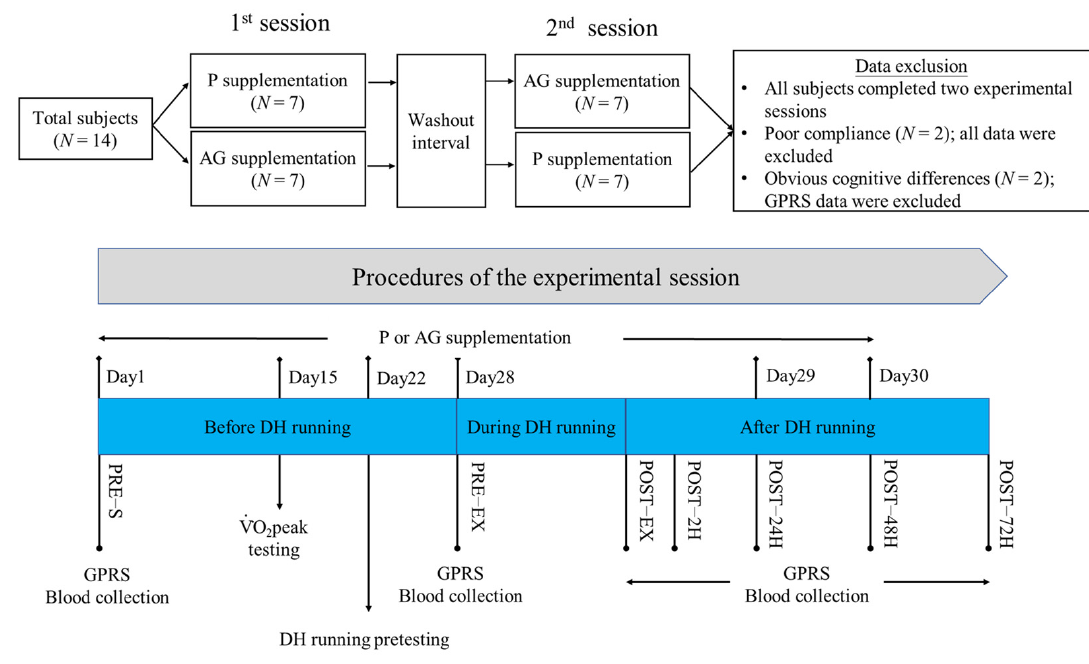
Figure 1. Experimental arrangement and procedure. AG: American ginseng; DH: downhill EX: exercise; GPRS: graphic pain rating scale; P: